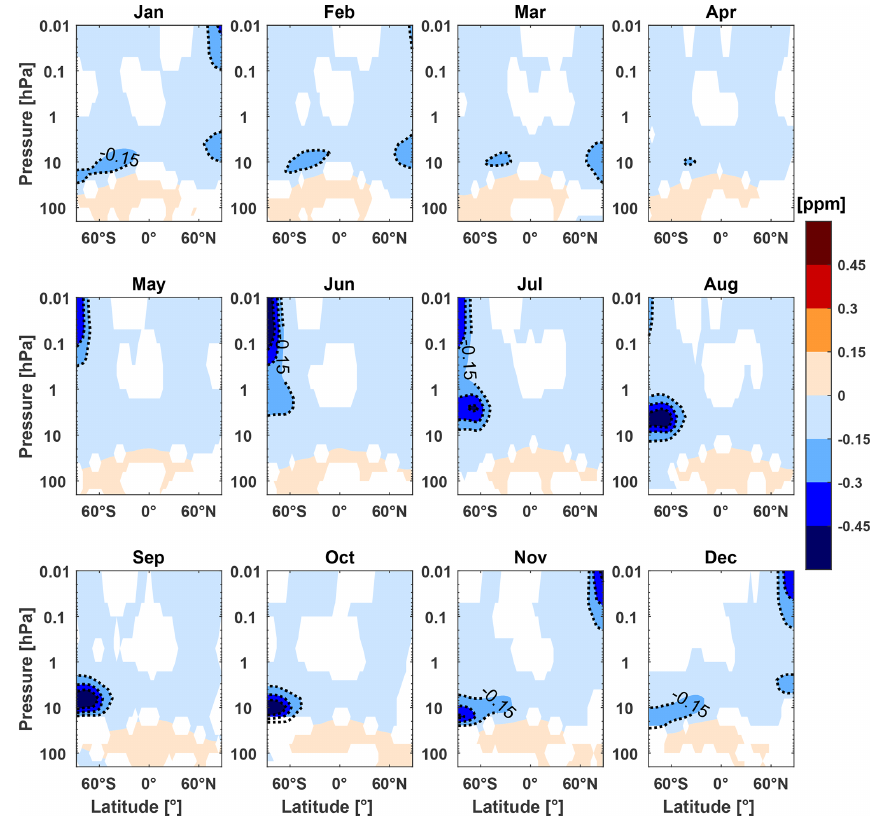
Figure 4. Absolute difference in the monthly zonal mean O 3 between EXP and REF during 1979–2008. Negative contour levels are − 0 . 15, − 0 . 3 and − 0 . 45 parts per million (ppm). Colour shading indicates areas significant at the 95% level, calculated with a Monte Carlo simulation and a false detection